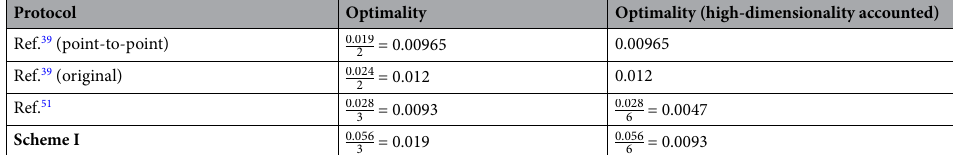
Table 4. Comparison between Scheme I and existing QKD protocols in terms of optimality F ( d ) for d = 10 km. When high-dimensionality (usage of two encodings) is accounted, the amount Q (Eq. 7) is doubled.